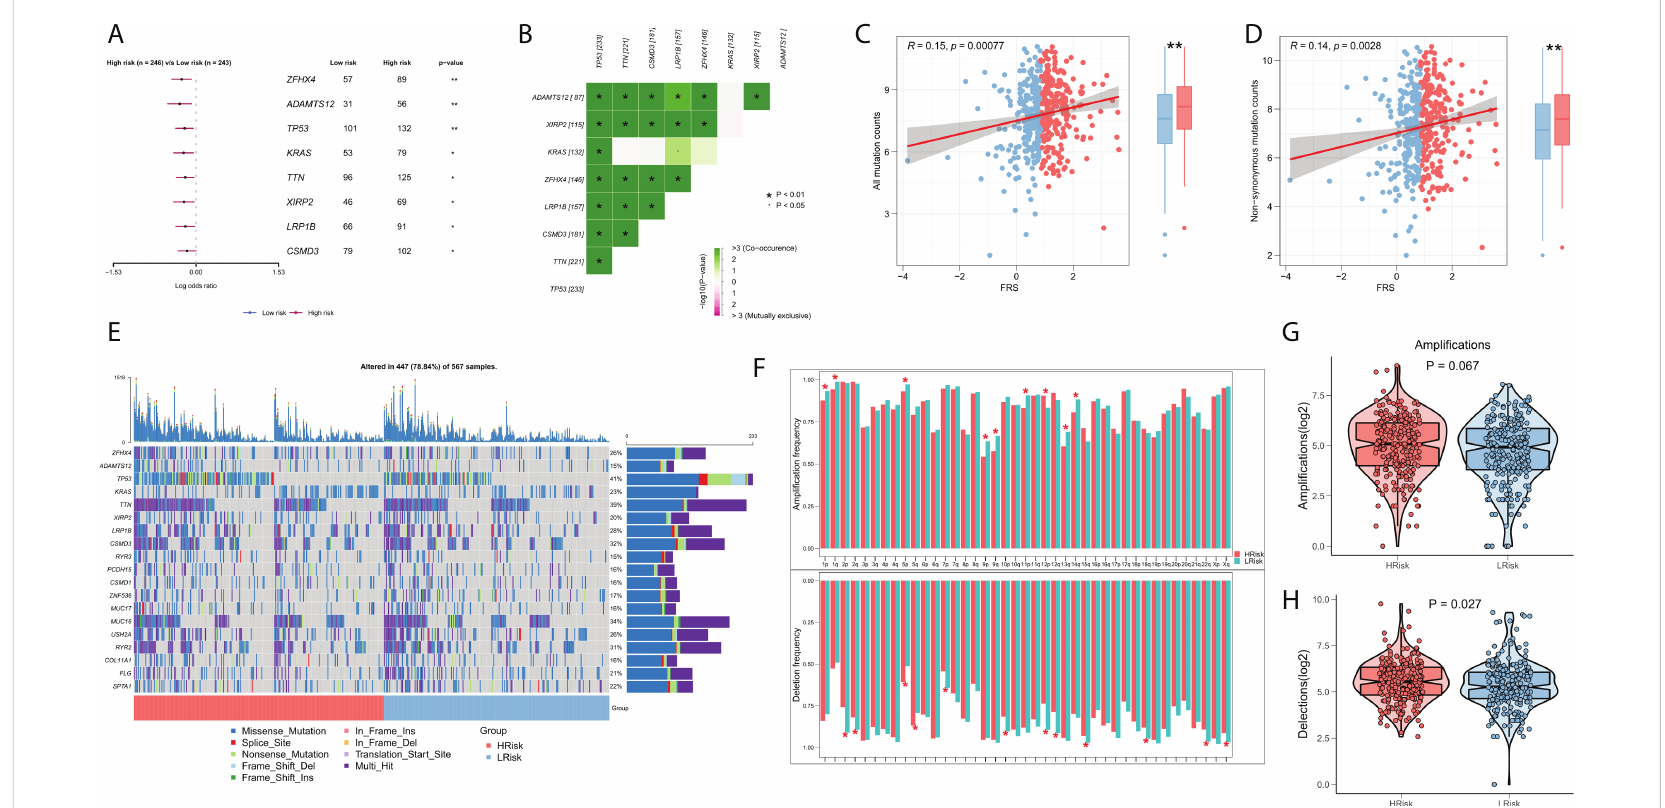
FIGURE 7 Genomic variation landscape of FRS. (A) Forest plots showing statistically signi fi cant differentially mutated genes between the high- and low-FRS groups; (B) Co-occurrence analysis of differentially mutated genes; (C) Correlation of FRS and all types of mutation burdens; (D) Correlation of FRS with non-synonymous mutation burden; (E) Oncoplot of high-frequency mutated genes between the high- and low-FRS groups; (F) Bar graph showing the CNV events on different chromosome arms in the high- and low-FRS groups; (G) Box plot showing the differences in the number of chromosome ampli fi cations between high- and low-FRS groups; (H) Box plots showing the differences in the number of chromosomal deletions high- and low-FRS groups. *p < 0.05; **p <